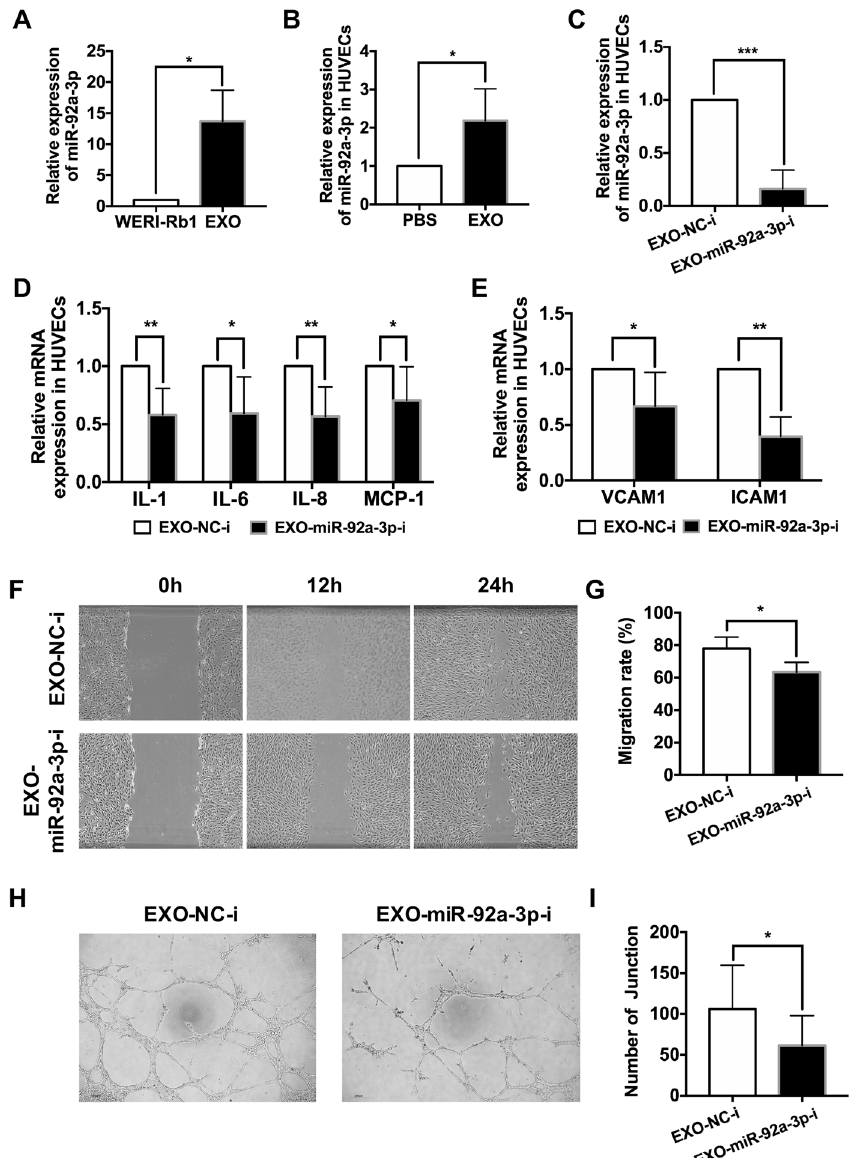
Fig. 5 Exosomal miR-92a-3p promotes HUVEC angiogenesis and migration in vitro. A miR-92a-3p showed higher expression in the EXOs than in the WERI-Rb1 cells ( n = 3, * P < 0.05). B miR-92a-3p was increased in the HUVECs treated with EXOs ( n = 5, *** P < 0.001). C – E HUVECs were incubated with EXOs transfected with synthetic inhibitor control (EXO-NC-i) or miR-92a-3p inhibitor (EXO-miR-92a-i). The mRNA levels of miR-92a-3p, VCAM1, ICAM1, IL-1, IL-6, IL-8, and MCP-1 were decreased ( n = 7, * P < 0.05, ** P < 0.01). F Wound-healing assay revealed that EXO- miR-92a-i could inhibit the migration rate of the HUVECs. G Relative quanti fi cation of HUVEC migration 24 h after the wound scratch ( n = 4, * P < 0.05). H , I Quantitative evaluation of number of the junctions after treating the HUVECs with EXO-NC-i or EXO-miR-92a-i (24 h, n = 10, * P <